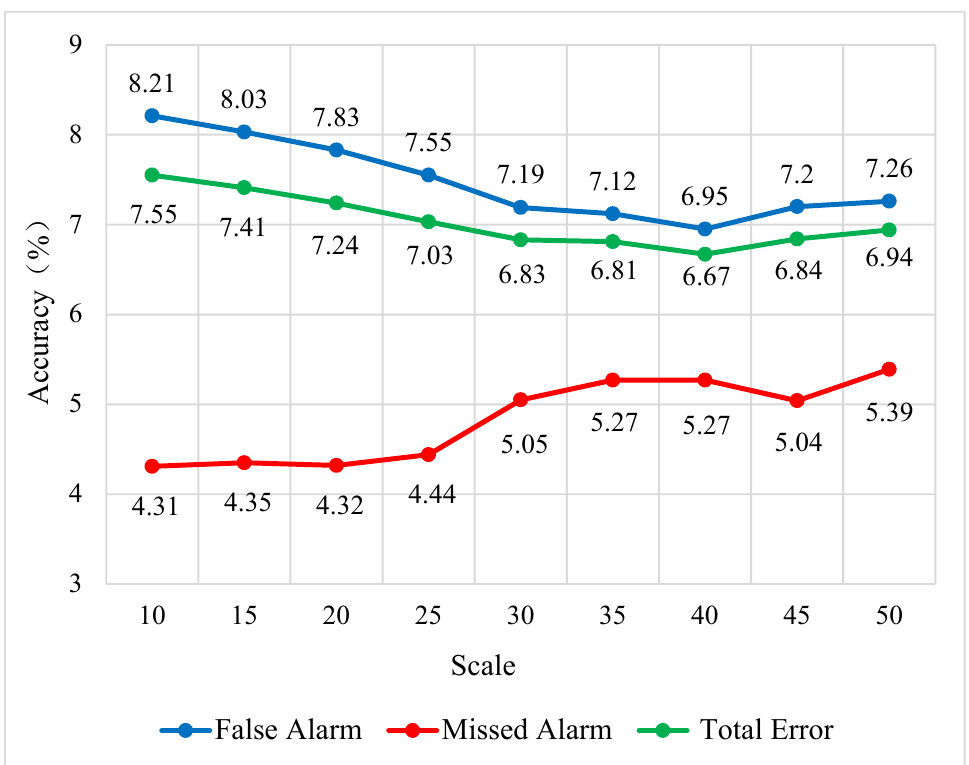
Figure 12. Relationship between the detection accuracies and the scale of the multi-scale segmentation in the proposed approach for the Ji’Nan Quick Bird Satellite images.